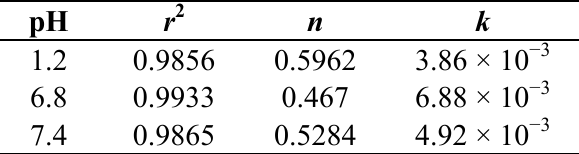
Table 2. Diffusional exponent ( n ) and constant ( k ) of cylindrical crosslinked hydrogel at different pH values from a fitted Peppas